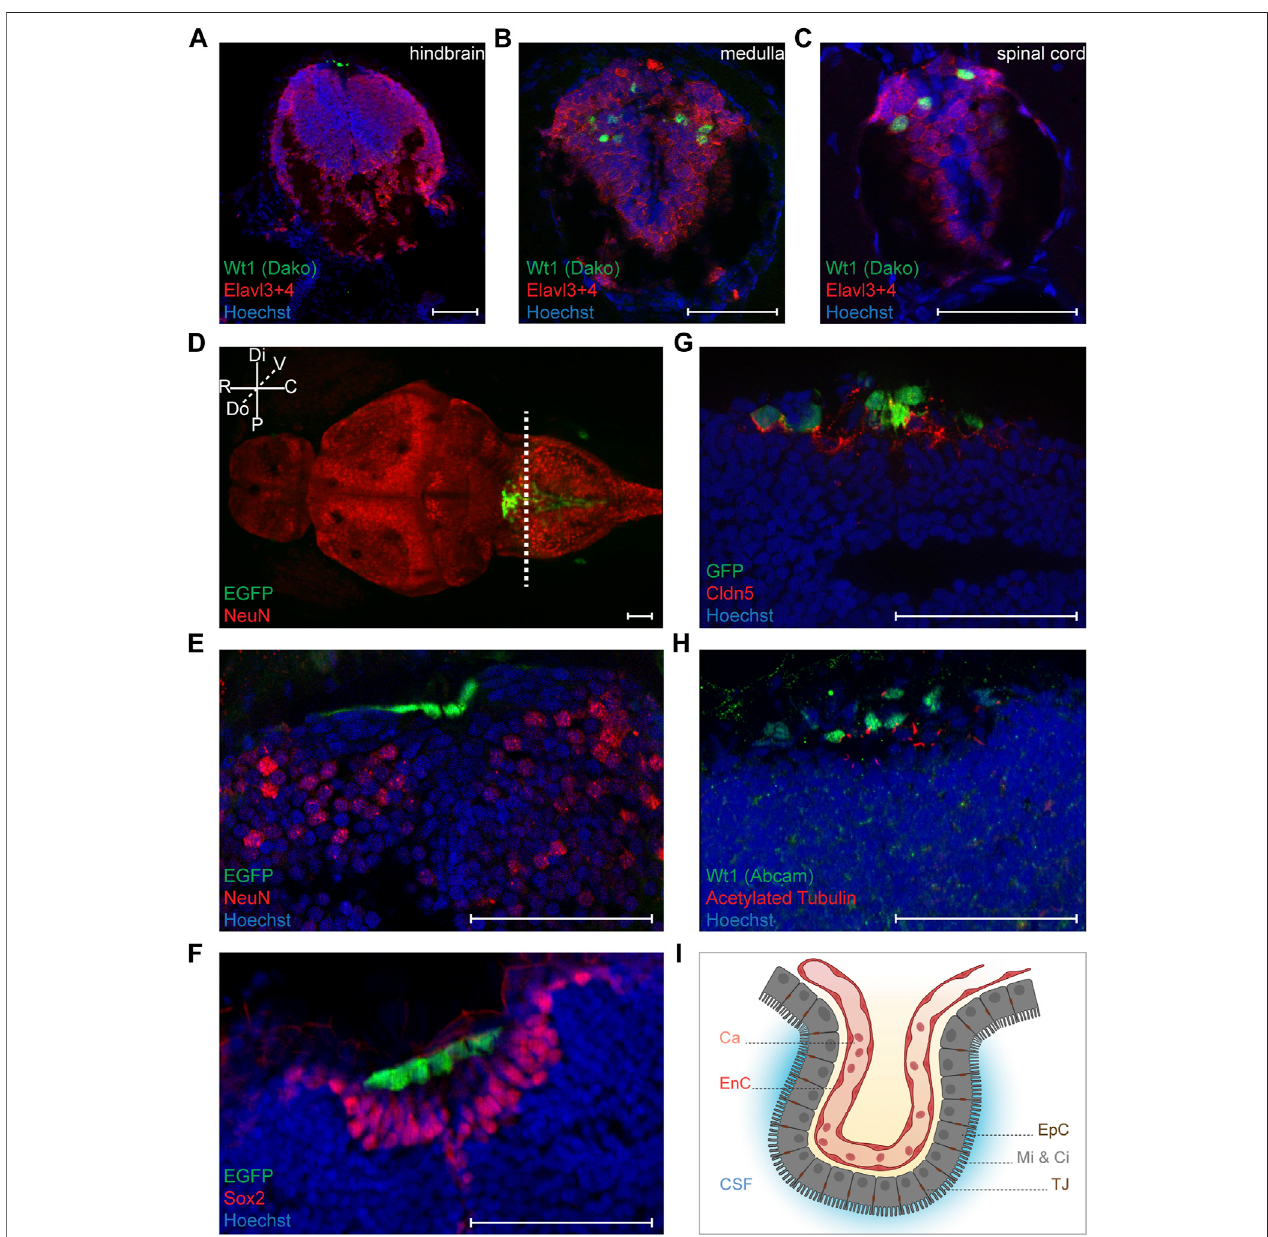
FIGURE 2 | Characterization of Wt1+ cells of the zebra fi sh larval CNS. (A-C) Transverse sections through the hindbrain, the caudal medulla and spinal cord of 4.25 days old Tg(wt1a:EGFP) zebra fi sh larvae were stained with antibodies against Wt1 (Dako) and Elavl3+4. The images show optical sections of one focus plane. Orientation: dorsal: up. Scale bar: 50 µm. (D) Whole zebra fi sh larvae (4.5 dpf) of the Tg(wt1a:EGFP) line were used for detection of the EGFP signal of Wt1 positive cells and IHC against NeuN. The image is displayed as extended depth of focus projection. The fl uorescence signal for EGFP does not overlap with NeuN staining. The dottedlineindicatesthecuttingpositionofthefollowingtransversesections.Orientation:rostral:left;dorsalview.Abbreviations:distal(Di);proximal(P);rostral(R);caudal (C);dorsal(Do);ventral(V)Scalebar:50 µm. (E) Transversesectionthroughthehindbrainof4.25 daysold Tg(wt1a:EGFP) zebra fi shlarvaewereusedfordetectionofthe EGFP signal of Wt1 positive cells and IHC against NeuN. (F) Transverse sections through the hindbrain of 4.25 days old Tg(wt1a:EGFP) zebra fi sh larvae were used for detection ofthe EGFP signal ofWt1 positive cells and IHC against Sox2. (G) Transversesections through the hindbrain of 4.25 days old Tg(wt1a:EGFP) zebra fi sh larvae wereusedforIHCagainstGFPandCldn5. (H) Transversesectionsthroughthehindbrainof4.25 daysold Tg(wt1a:EGFP) zebra fi shlarvaewereusedforIHCagainstWt1 (Abcam) and acetylated Tubulin. (E – H) The images show optical sections of one focus plane. Orientation: dorsal: up. Scale bar: 50 µm. (I) Schematic illustration of the ependymal cells of the fourth brain ventricle, which are connected via tight junctions and show microvilli and cilia at their apical surface. The image was created with BioRender.com. Abbreviations: capillary (Ca); endothelial cell (EnC); cerebrospinal fl uid (CSF); ependymal cells (EpC); microvilli (Mi); Cilia (Ci); tight junction (TJ).